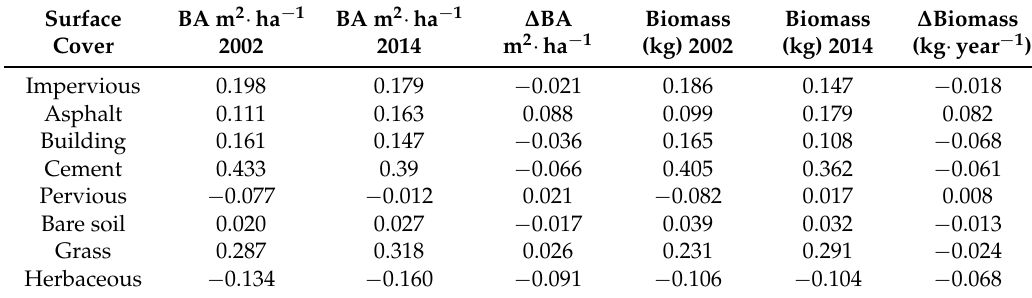
Table 7. Spearman correlation coefficients, r, for basal area (BA), basal area change ( ∆ BA), biomass (kg), and biomass change ( ∆ Biomass) according to 2002 and 2014 surface covers in Santiago,